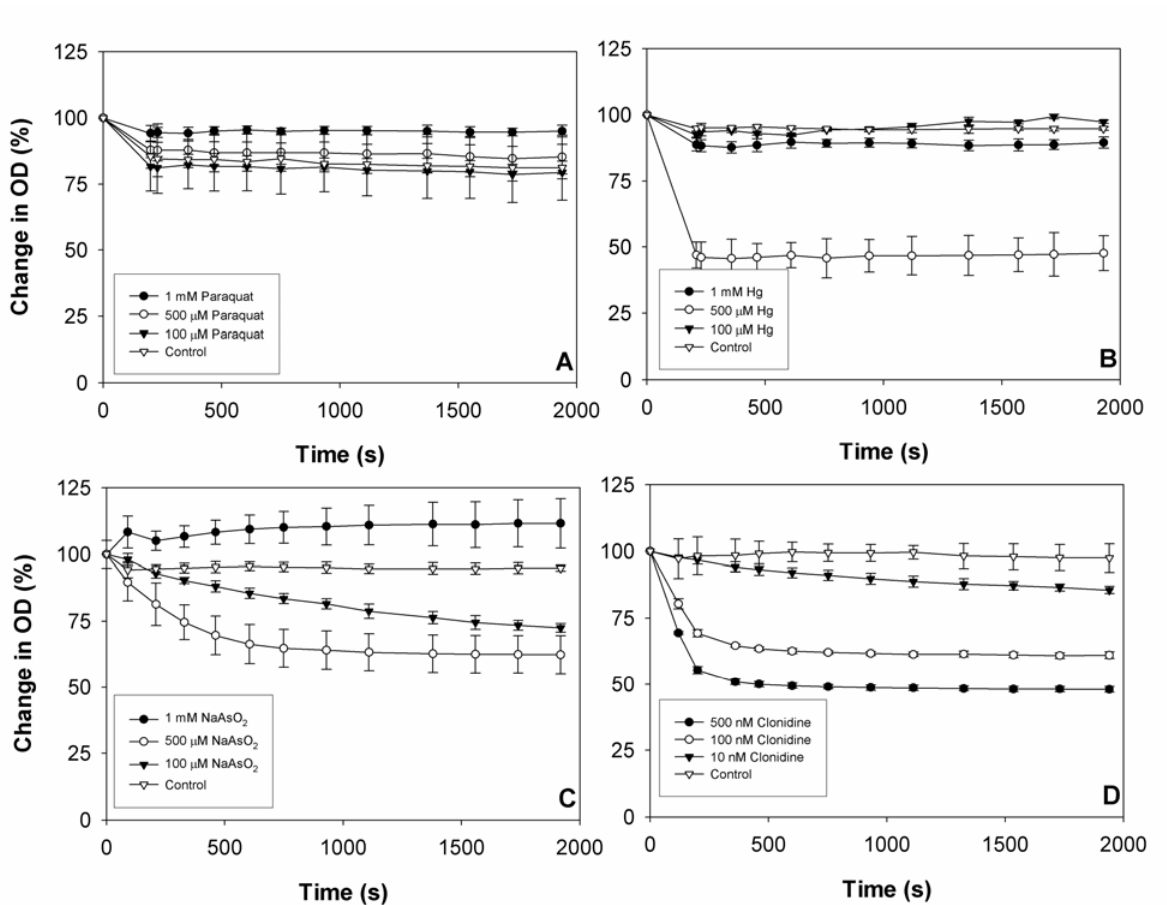
Figure 2. Representative chromatophore responses to model compounds (A) Chromatophores exposed to paraquat. (B) Chromatophores exposed to mercury (HgCl ). (C) Chromatophores exposed to sodium arsenite (NaAsO 2 exposed to